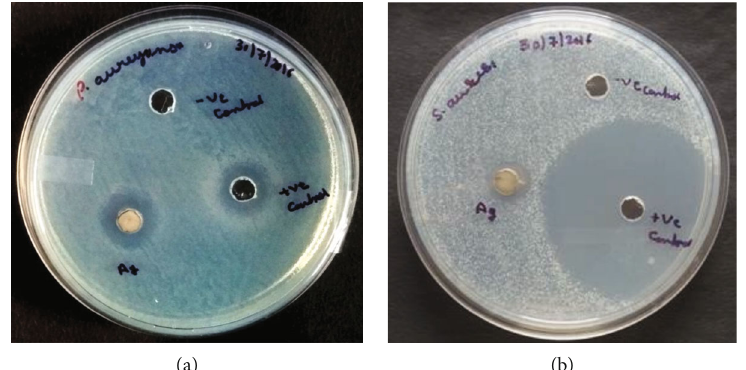
Figure 9: Antibacterial activity of fi lm solution against P. aeruginosa and S.